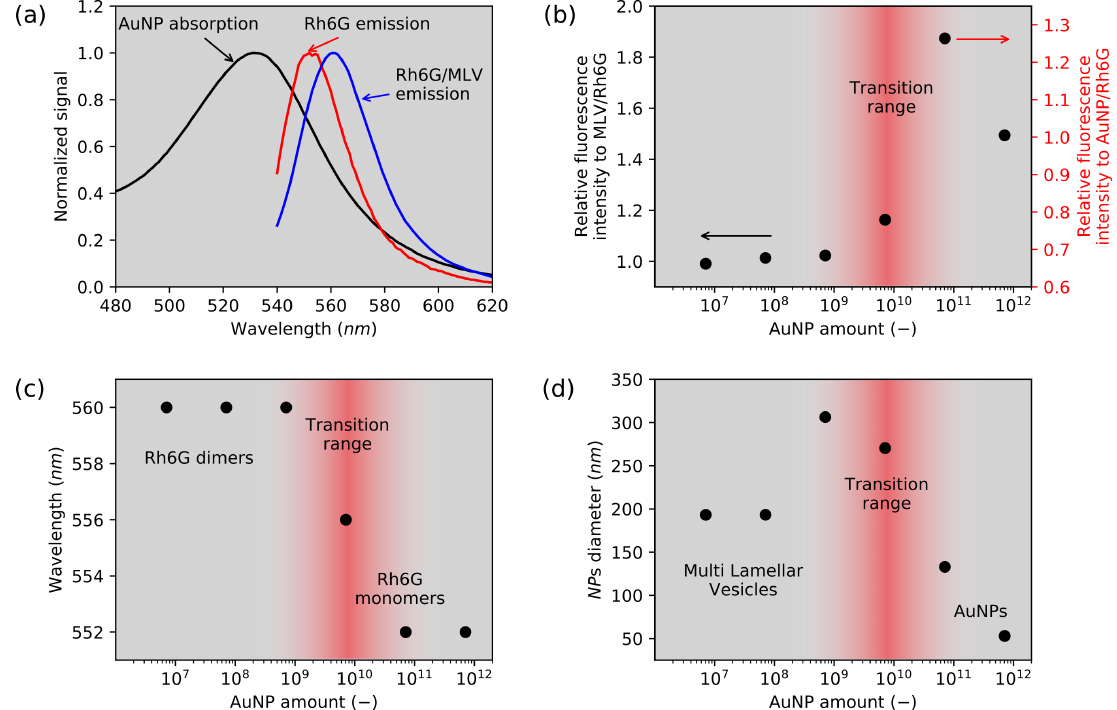
Figure 2. ( a ) normalized Au nanoparticles absorption spectrum (black); rhodamine 6G emission spectra in water solution (red), and MLV (blue); ( b ) relative fluorescence intensity of samples containing Rh6G, MLV with AuNPs measured according to the liposomes suspension with Rh6G; ( c ) variance of maximum Rh6G fluorescence wavelength dependence as a function of the AuNP concentration in the presence of α -PC lipids; ( d ) mean hydrodynamic diameter of samples containing MLV, Rhodamine 6G and AuNPs in a function of nanoparticle amount. At the lowest concentration, only MLVs are visible, but, at higher concentrations, only AuNP are detected by the DLS ( d = 53